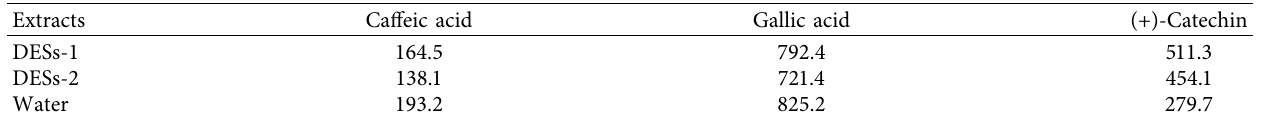
Table 4: Concentration of predominant compounds ( μ g/g).